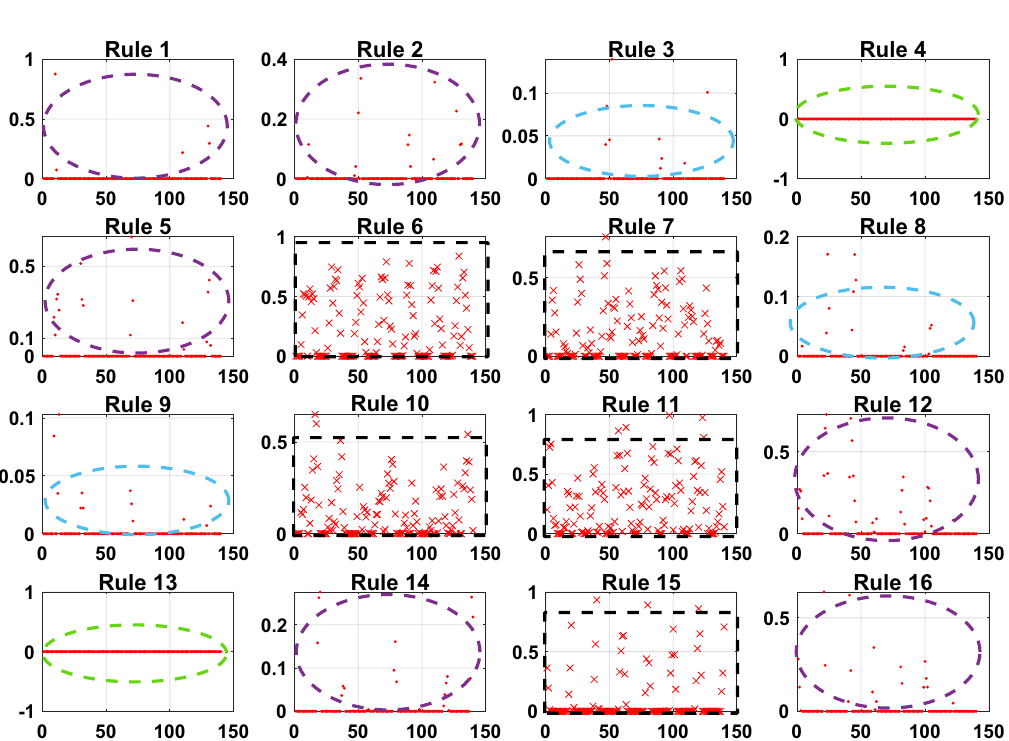
Figure 13. Analysis of Sub-BRB2 rule activation weights (x-axis represents test data, y-axis represents activation